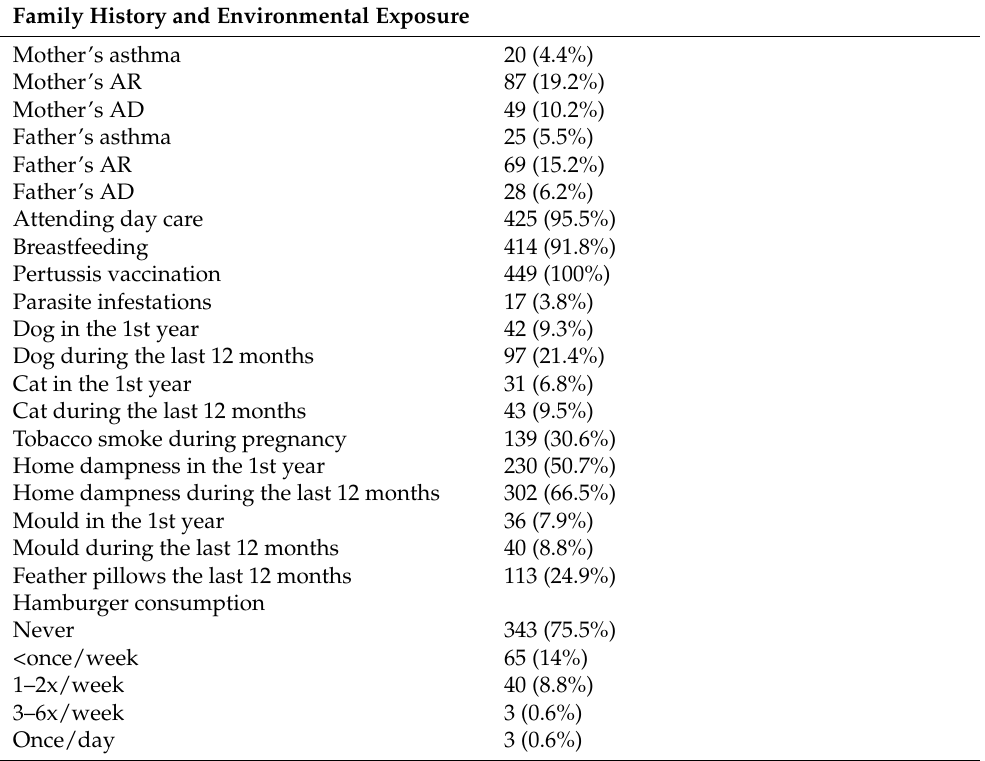
Table 2. Family history and environmental exposure in the study population in